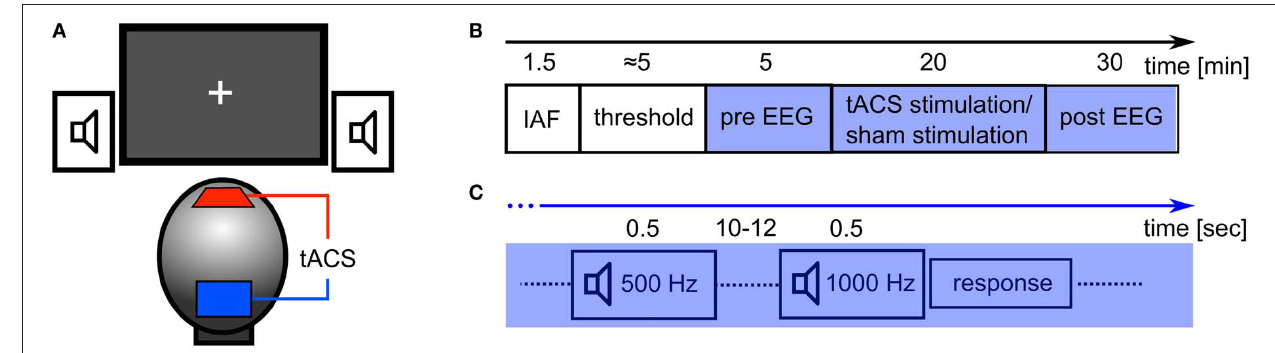
FIGURE 2 | Experimental details. (A) Experimental setup: tACS electrodes were centered at electrode positions Cz and Oz of the 10/20 system. Subjects were seated in front of a computer screen with a gray fixation cross on a black background (Experiment 2). Auditory stimuli were delivered through stereo speakers. (B) Sequence of the experiment: at first, the participant’s IAF was obtained with their eyes closed, before the thresholds for skin sensation and phosphene perception were acquired. In the following 55min, participants had to